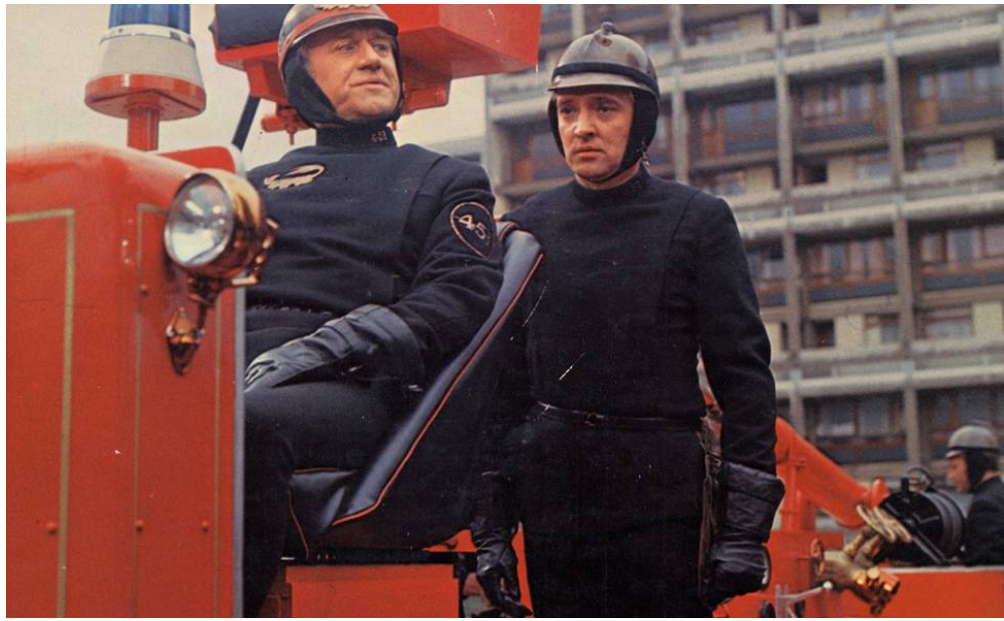
Figure 1. The characters of Beatty and Montag in François Truffaut’s film of Fahrenheit 451 , 1966